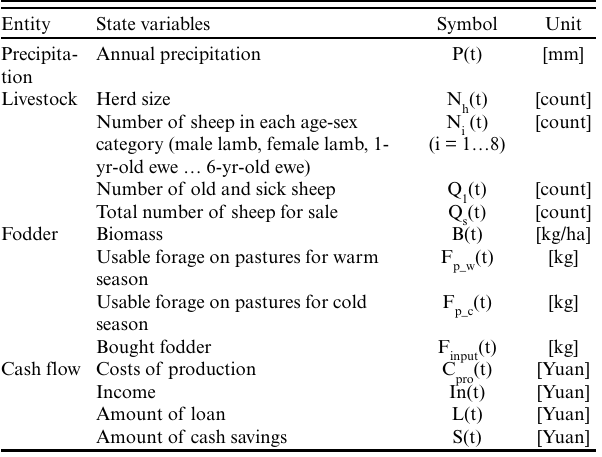
Fig. 2 . Key processes in a rangeland social-ecological system in the study area. Notes: The figure shows how pasture forage, herd size and structure, and cash flow are interlinked and changed in one production cycle. The variables in grey boxes are the key factors of pastoralists’ stocking decisions. The starting point of the arrow is the driving factor and the end is the affected factor. The lines with two-way arrows indicate that the two variables are interactive. WS - warm season, CW - cold season, WSP - warm-season-pasture, CSP - cold-season-